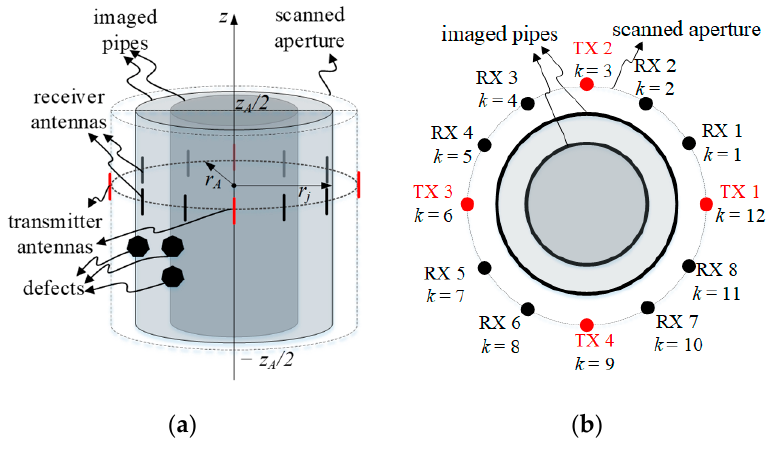
Figure 1. ( a ) Illustration of the imaging setup and ( b ) top view of the setup.